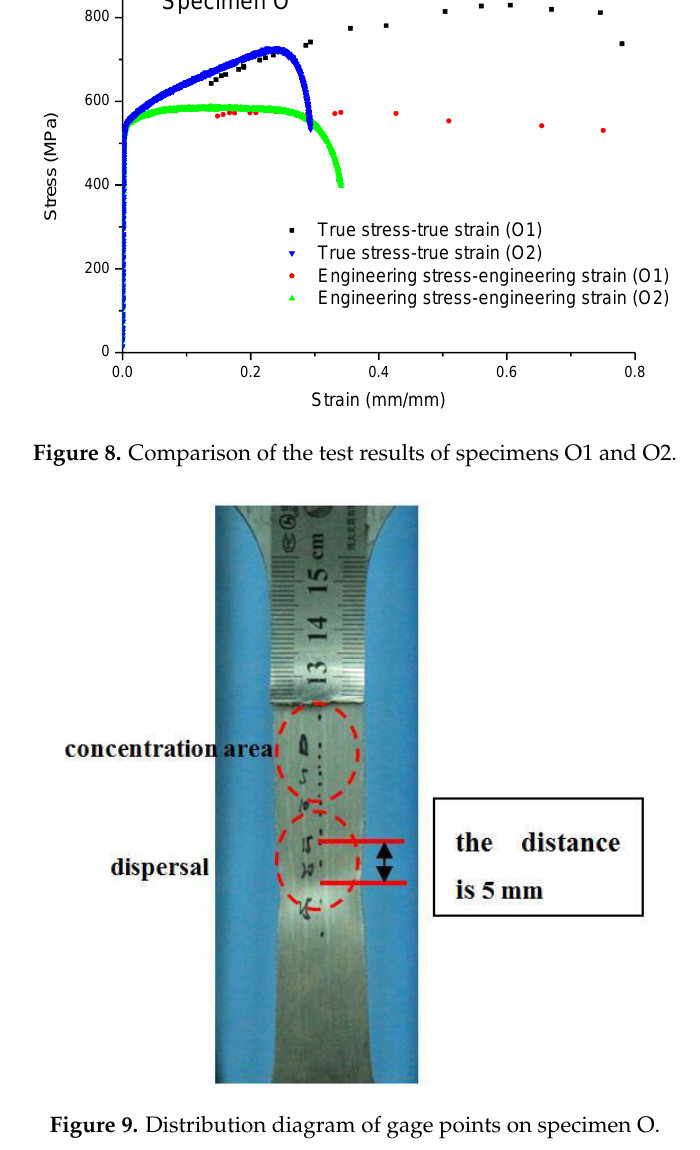
Figure 9. Distribution diagram of gage points on specimen O.